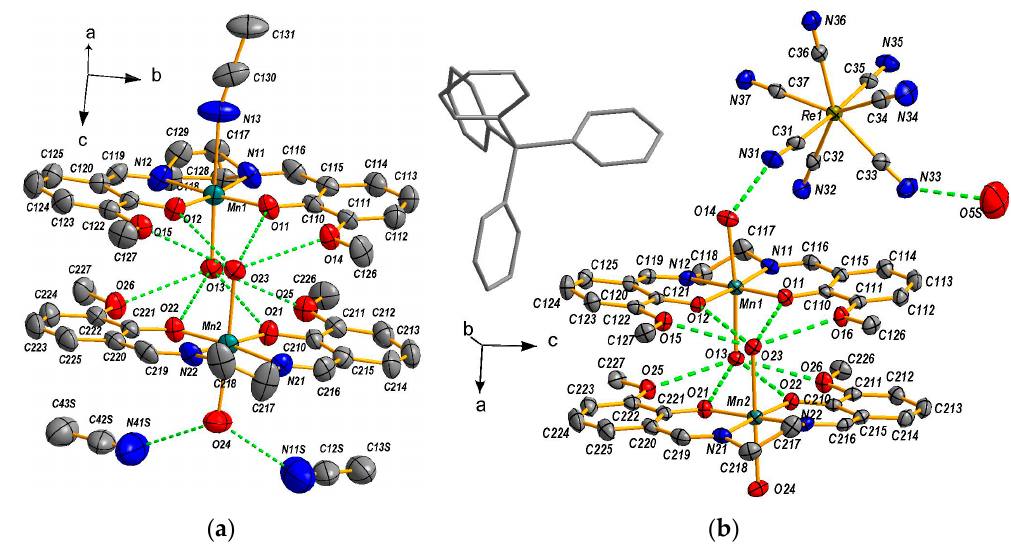
Figure 2. ( a ) Cationic dimer unit with numbering scheme for the compound 6 ; ( b ) Asymmetric unit with numbering scheme for the compound 3 . The Ph 4 B − anion is tinted by a grey color. The green lines are hydrogen bonds. Hydrogen atoms and some solvent molecules are omitted for clarity.